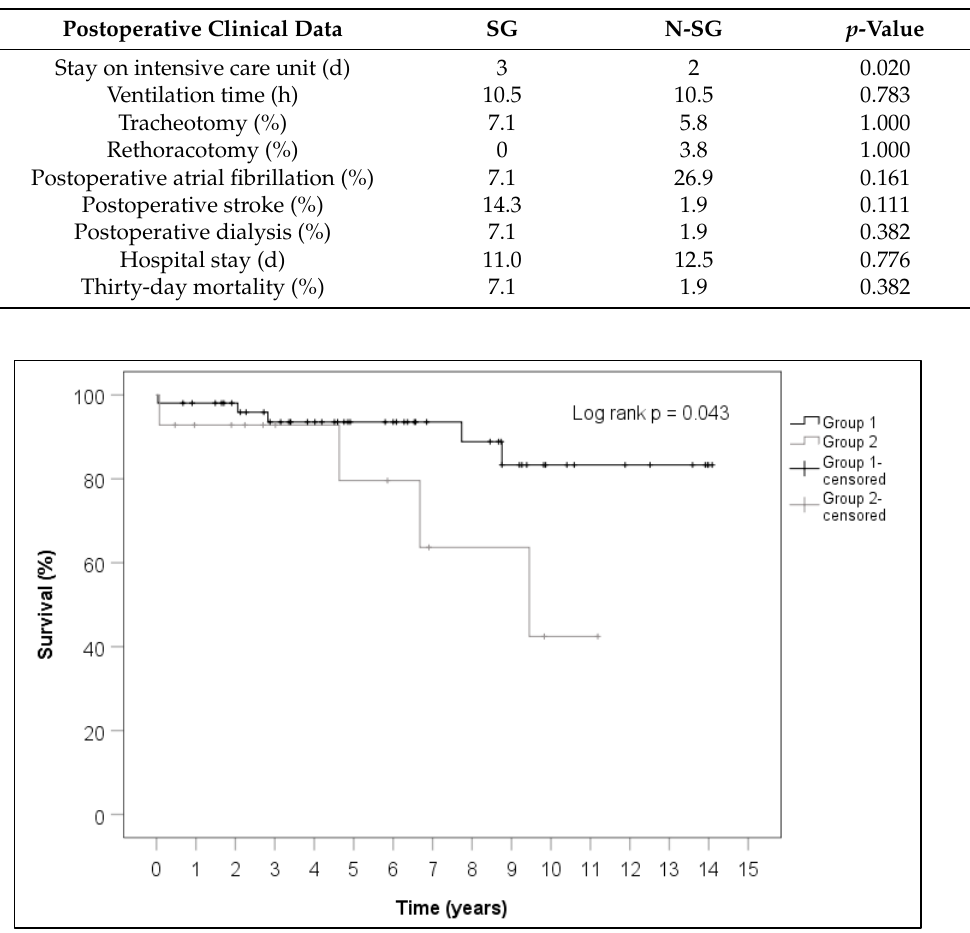
Figure 6. Kaplan – Meier curves of group 1 (N-SG) and group 2 (SG) with right-censored survival for both groups.